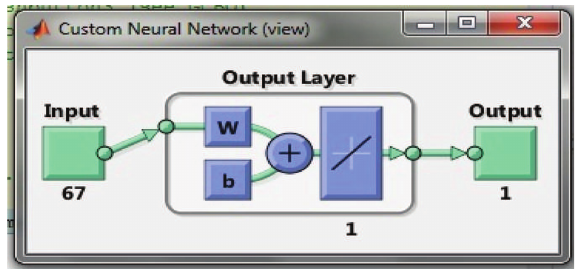
Figure 4: Neural Network Structure Obtained for the Proposed Method.